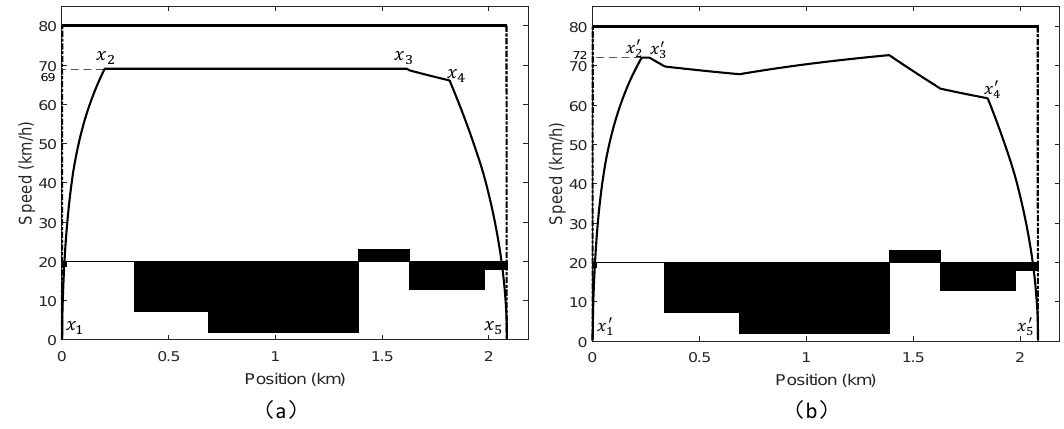
Figure 8. Energy-efficient driving strategies calculated with: ( a ) the classical algorithm; and ( b ) the proposed approach.